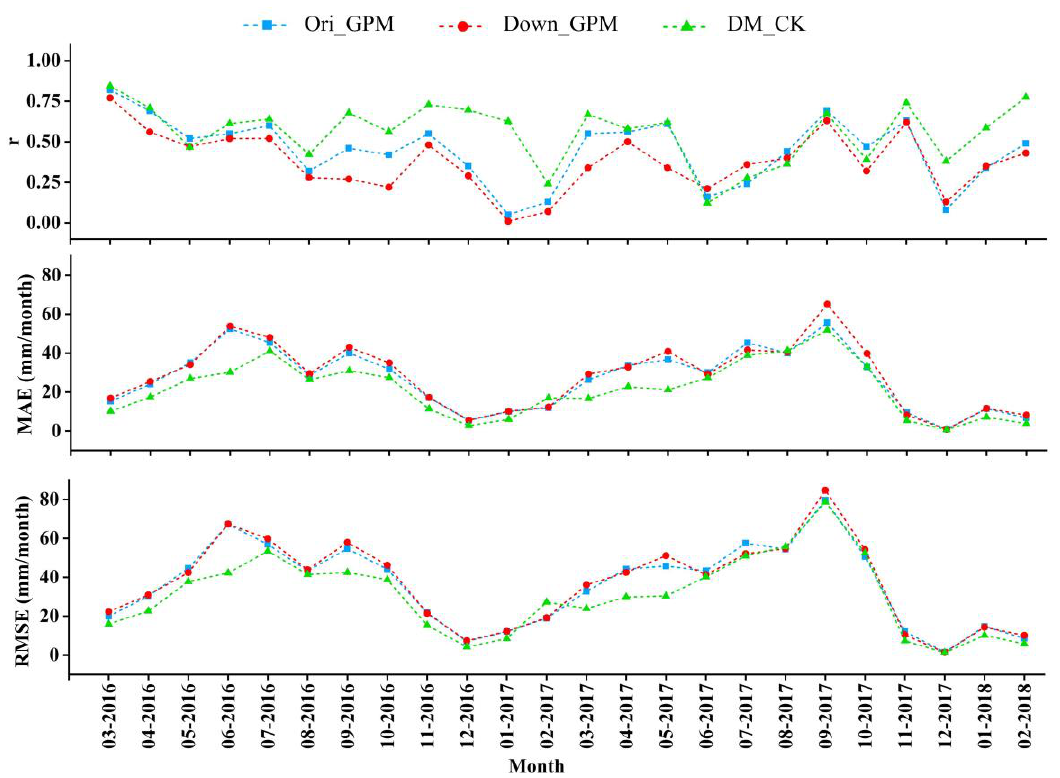
Figure 10. Evaluation for quantitative indices of the Ori_GPM, Down_GPM, and DM_CK for monthly precipitation estimates with the time variation from March 2016 to February 2018.